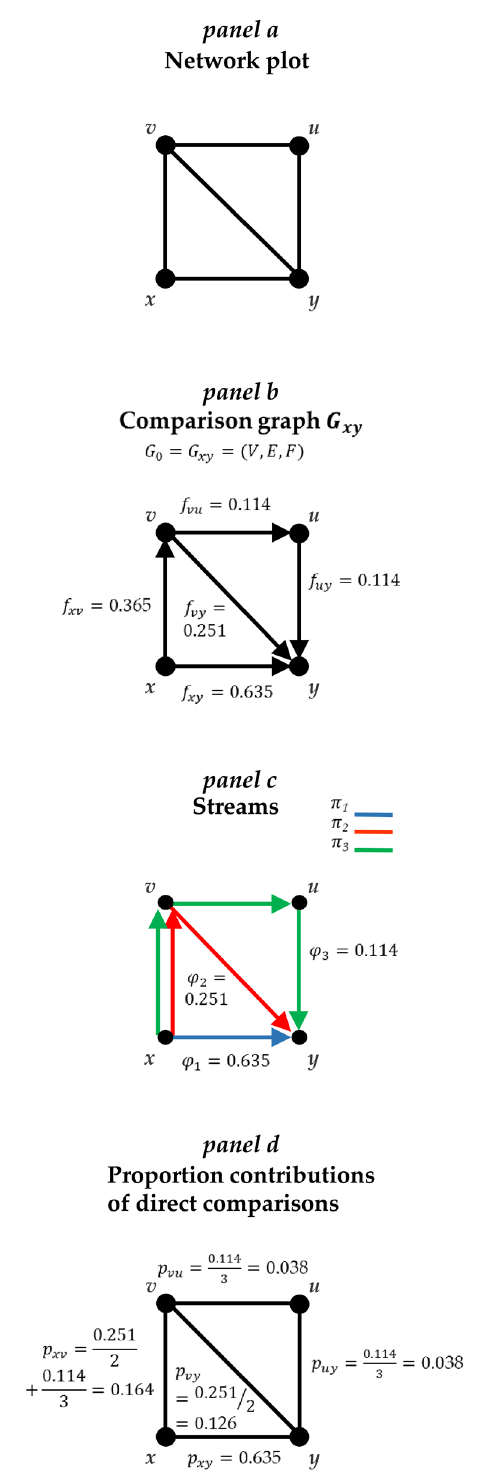
Figure 1. Network plot for the network of topical antibiotics without steroids for chronically discharging ears (a), comparison graph corresponding to the h xy row of H matrix (b), flows f with respect to the ‘ x versus y ’ network meta-analysis uv treatment effect are indicated along the edges), streams (c) and proportion contributions of each direct comparison (d). x , no treatment; y , quinolone antibiotic; u , non-quinolone antibiotic; v ,